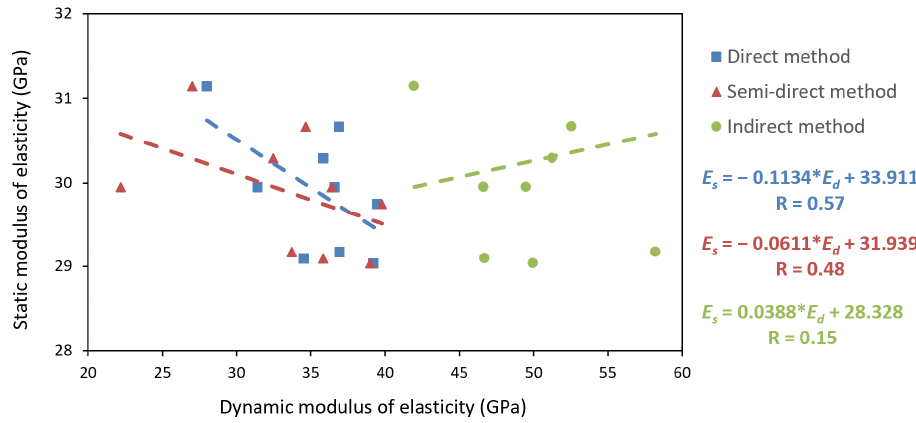
Figure 17. Correlation between the dynamic and the static modulus of elasticity.